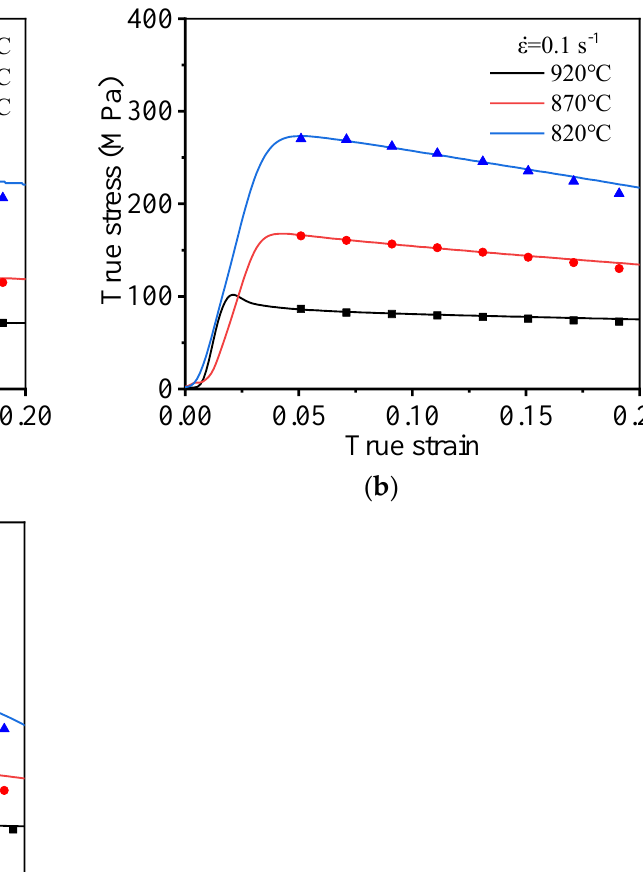
Figure 11. Experimental and predicted values at different deformation conditions: ( a ) 0.01 s −1 ; ( b ) 0.1 s −1 ; ( c ) 0.28 s −1 .